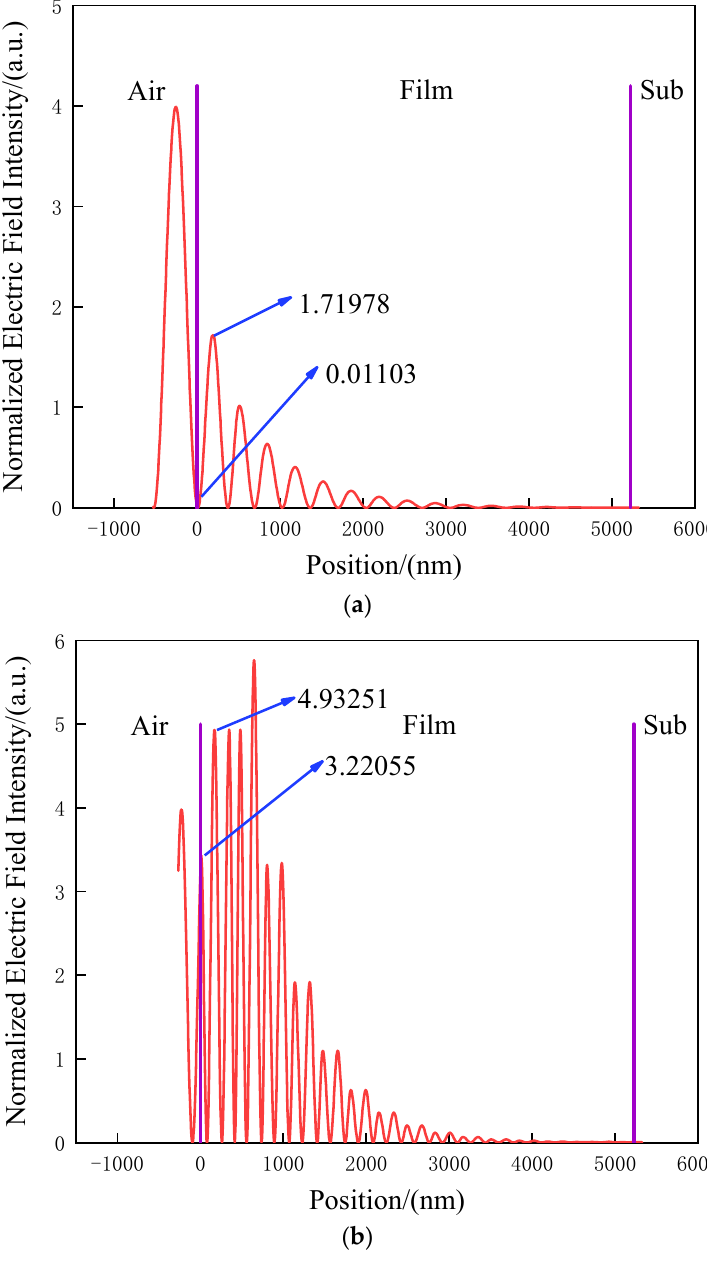
Figure 6. Relative standing-wave electric field intensity distribution of the non-regularized highly reflective HfO 2 /SiO 2 film at ( a ) 1064 nm and ( b ) 532 nm ( The red line indicates the simulated electric field strength of the film, the purple line at the air-film interface indicates the film surface location, and the purple line at the film-substrate interface indicates the film thickness location ; the value of the field strength at the interface between air and film is the interfacial electric field strength, and the first peak of the electric field strength inside the film is the peak electric field strength).